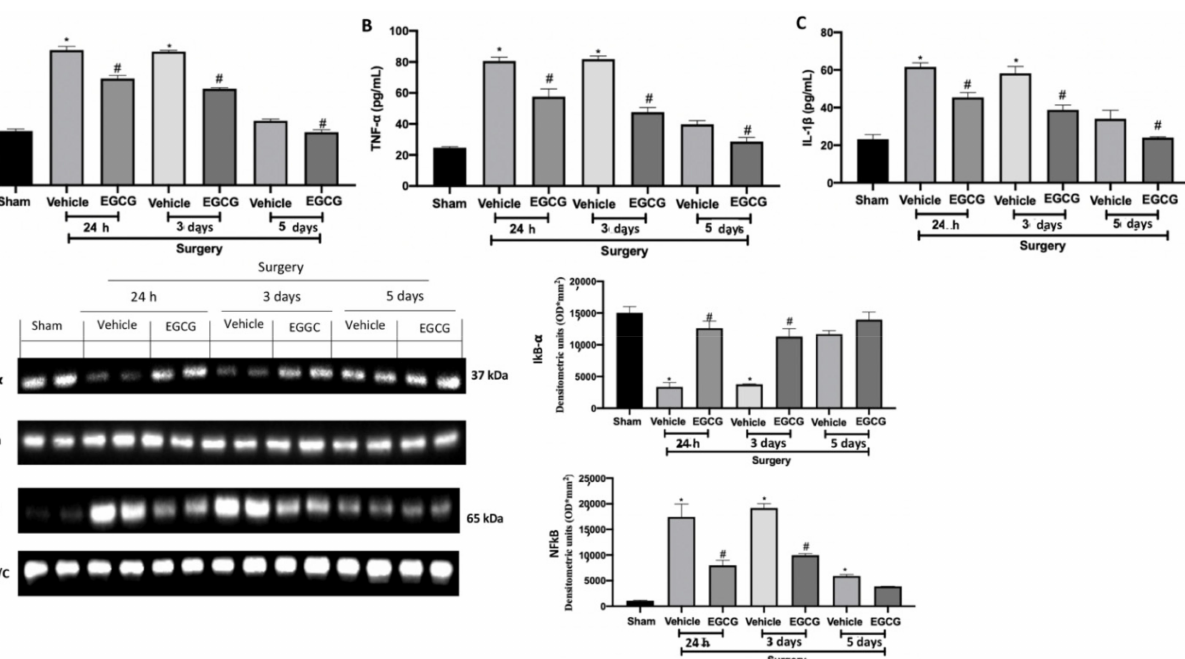
Figure 6. EGCG administration reduced cytokines and NFkB pathway activation: IL-18 ( A ), TNF- α ( B ), and IL-1 β ( C ), Western blot analysis of: IkB- α ( D ) and NFkB ( E ) expression. A p -value of less than 0.05 was considered significant. * p < 0.05 vs. sham, # p < 0.05 vs.